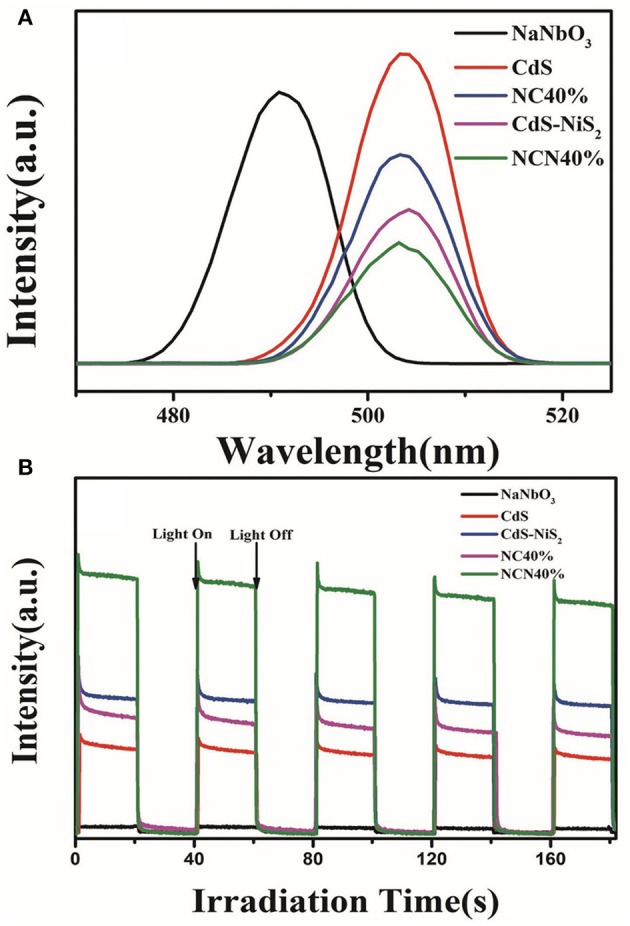
(A) Photoluminescence spectra of CdS, NaNbO3, CdS-NiS2, NC40%, and NCN40%. (B) Transient photocurrent response of CdS, NaNbO3, CdS-NiS2, NC40%, and NCN40% under visible light irradiation.